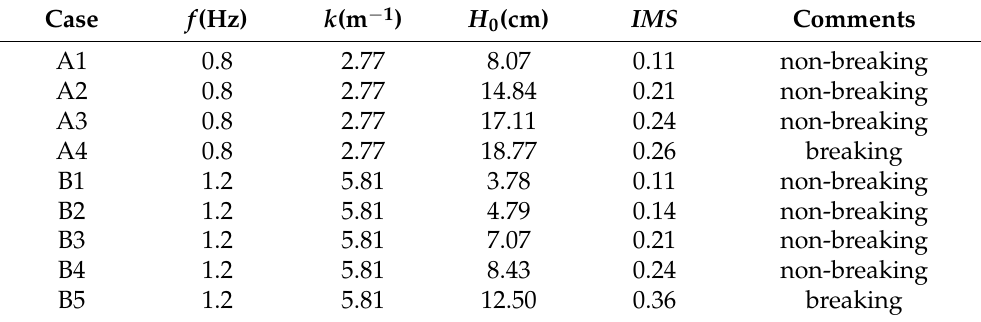
Table 1. Wave parameters. (In this table, f represents the frequency; H 0 represents the initial wave height at x = 3.5 m; IMS = H 0 k /2 represents the initial wave steepness).